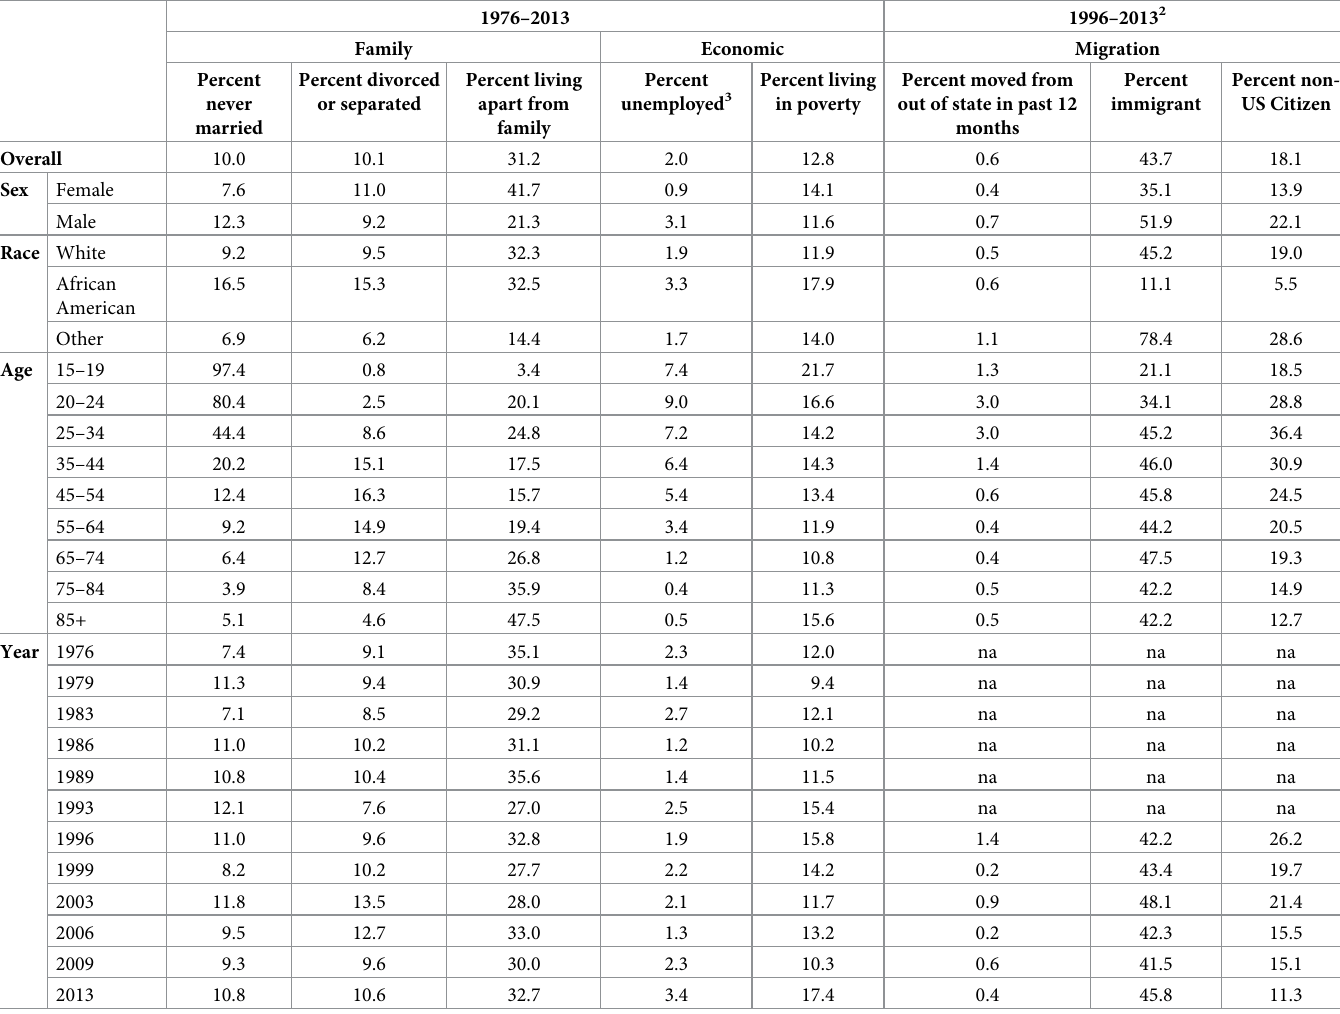
Table 2. Descriptive socioeconomic, family, and migration characteristics in Los Angeles County, weighted by deaths 1